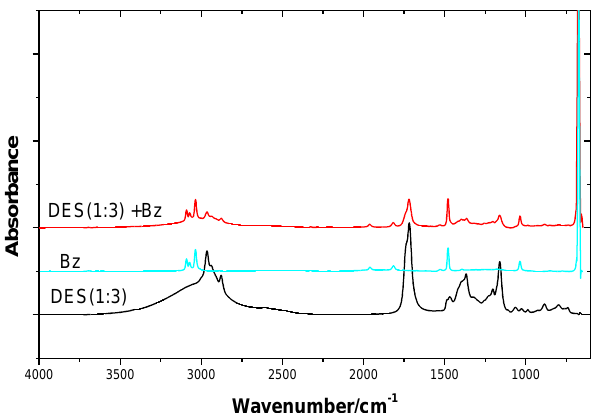
Figure 17. FT-IR spectra of DES(1:3), benzene and DES(1:3) + benzene(DES 0.1 (molar concentration)).